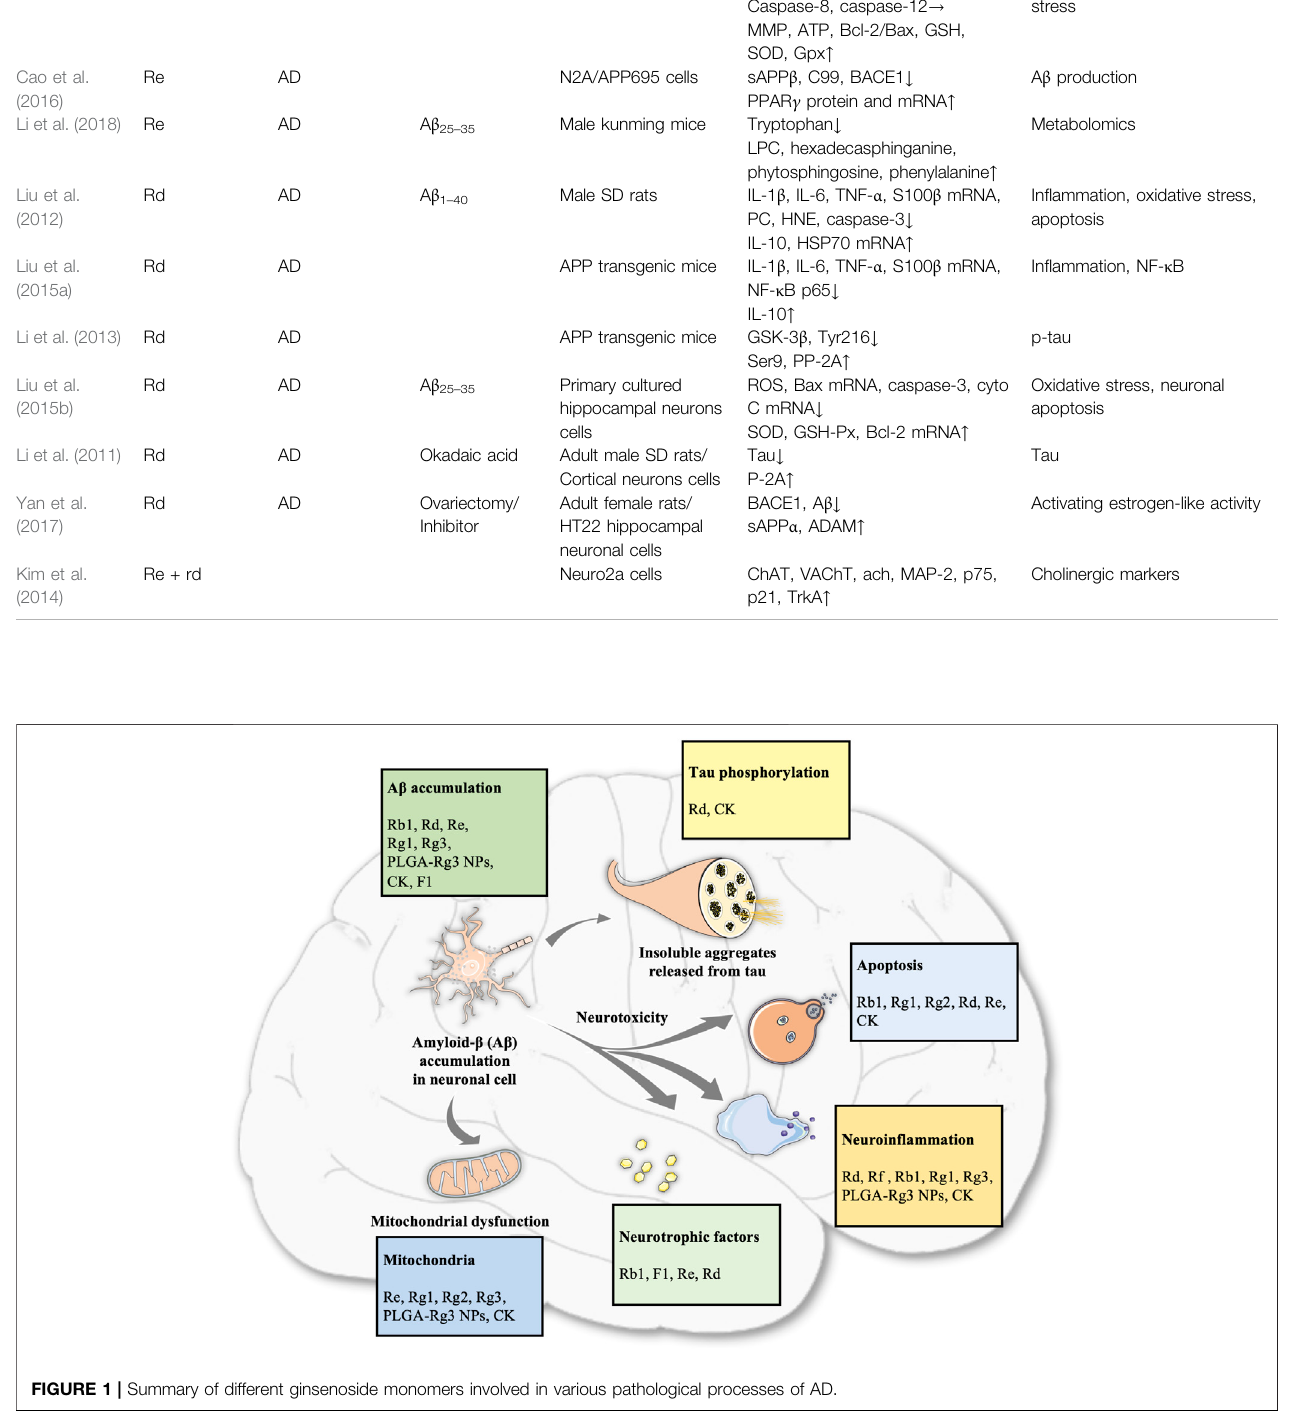
Frontiers in Pharmacology |